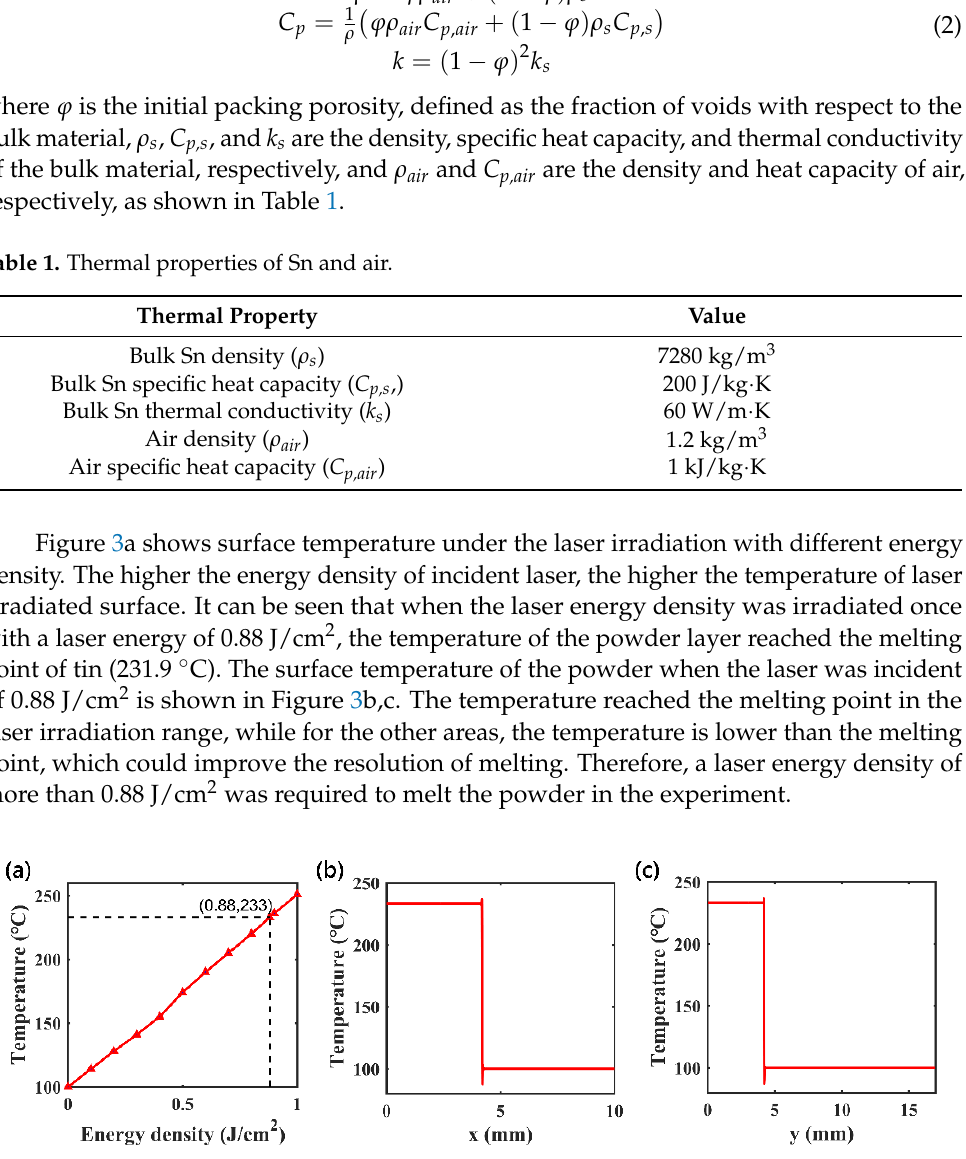
Figure 3. Finite-element simulation results. ( a ) Surface temperature under the laser irradiation with different energy density. ( b ) Temperature in the x-direction. ( c ) Temperature in the y-direction.